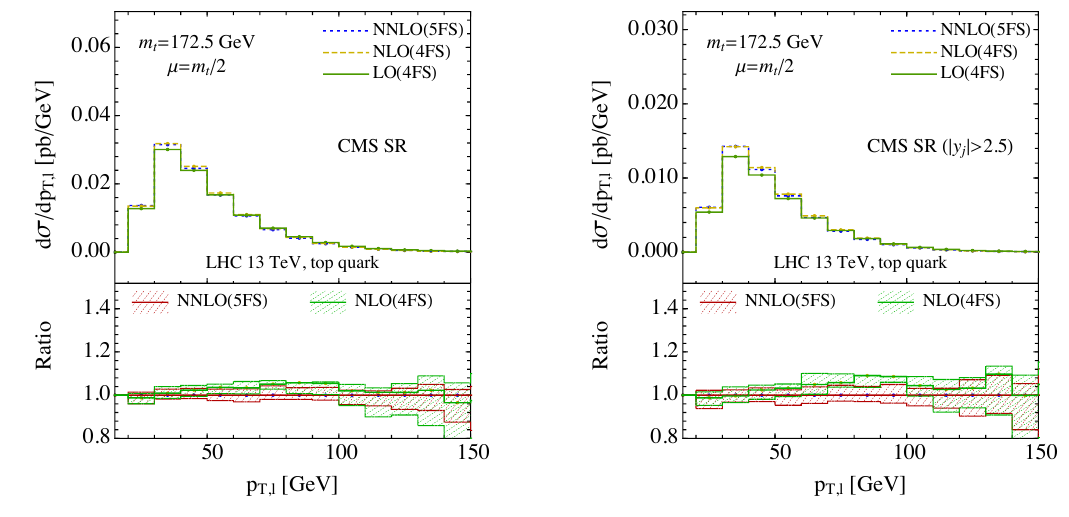
Figure 4 . Transverse momentum distribution of the charged lepton within the two fiducial regions at various orders in QCD for LHC 13 TeV, comparing 5FS with 4FS. Scale variations are evaluated by taking the envelop of results with 9 scale choices.